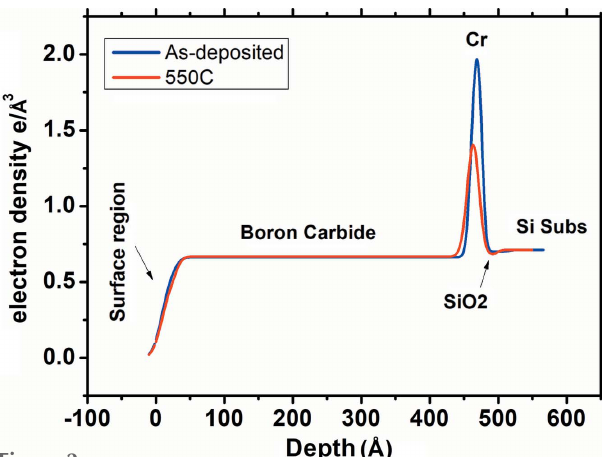
Figure 2 Electron density profile of as-deposited and 550 (cid:2) C annealed boron carbide/Cr bilayer samples as obtained from the GIXRR